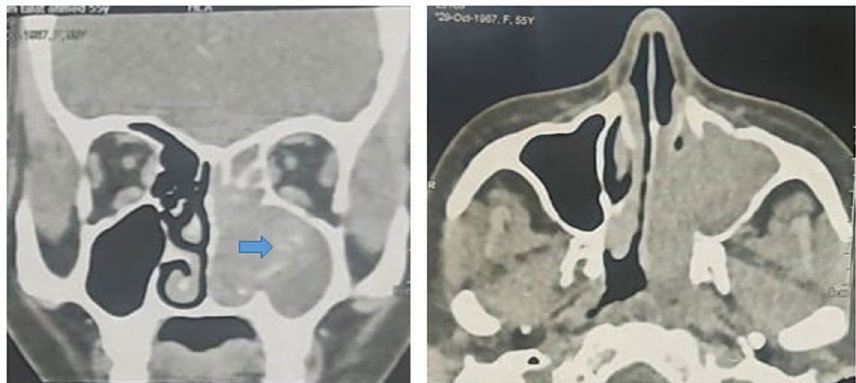
Fig. 3 A contrast-enhanced CT scan of the nose and PNS revealed minimal enhancement of the mass (blue arrow), without pterygopalatine fossa